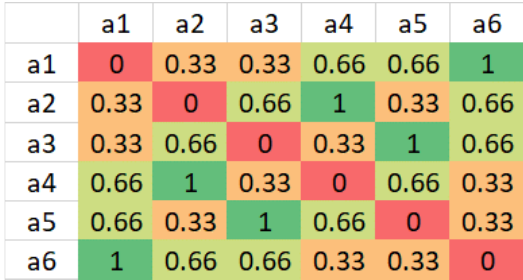
Figure 27. Kendall Tau-normalized distance change matrix in preferences.